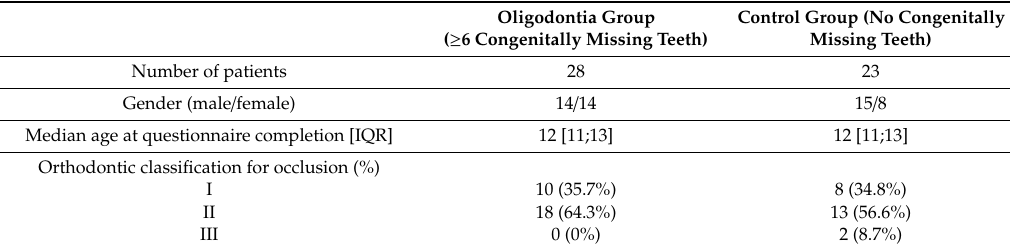
Table 1. Oligodontia and control group